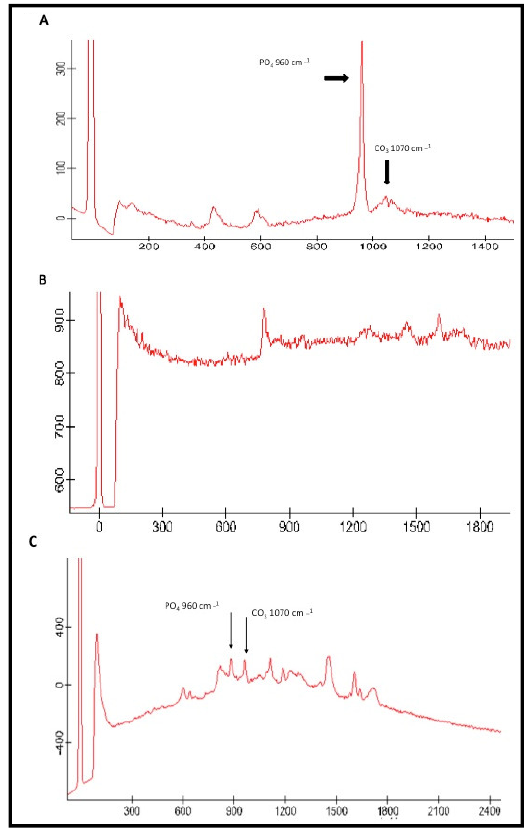
Figure 6. ( A ) Typical Raman spectra of the fabricated hydroxyapatite showing chemical groups identified by micro Raman analysis that could be identified as phosphate (υ1 PO 4 ≈ 960 cm −1 ) and carbonate (CO 3 ≈1070 cm −1 ). ( B ) Raman spectra of control adhesive and ( C ) HA-modified adhesive. The inclusion of HA nanoparticles in the adhesive is evidenced by the spectrum at 960 cm −1 for phosphate and 1070 cm −1 for carbonate.